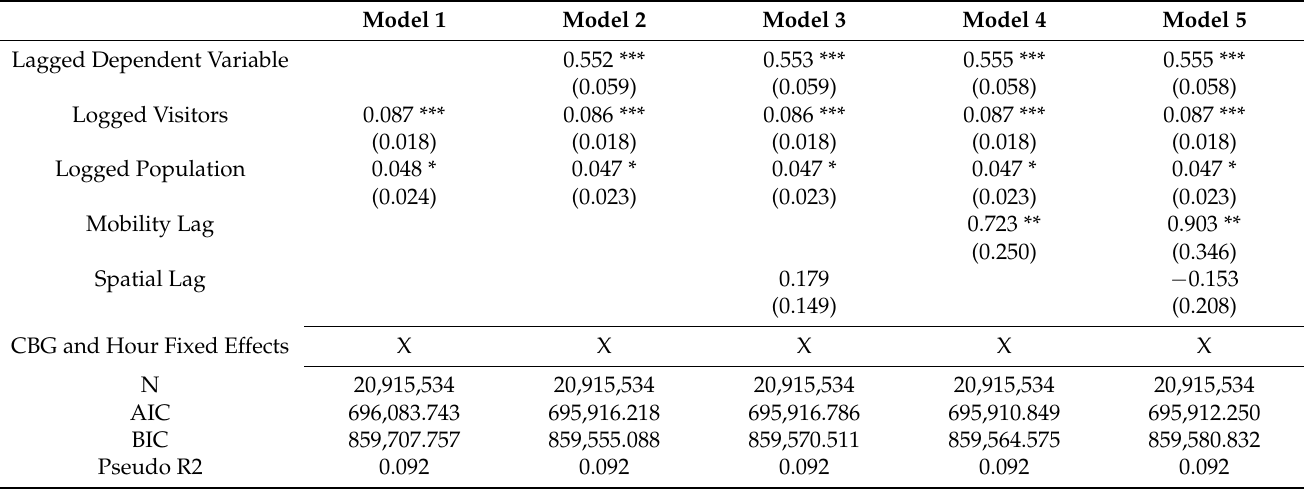
Table 5. Los Angeles Hourly Violent Crime Models.